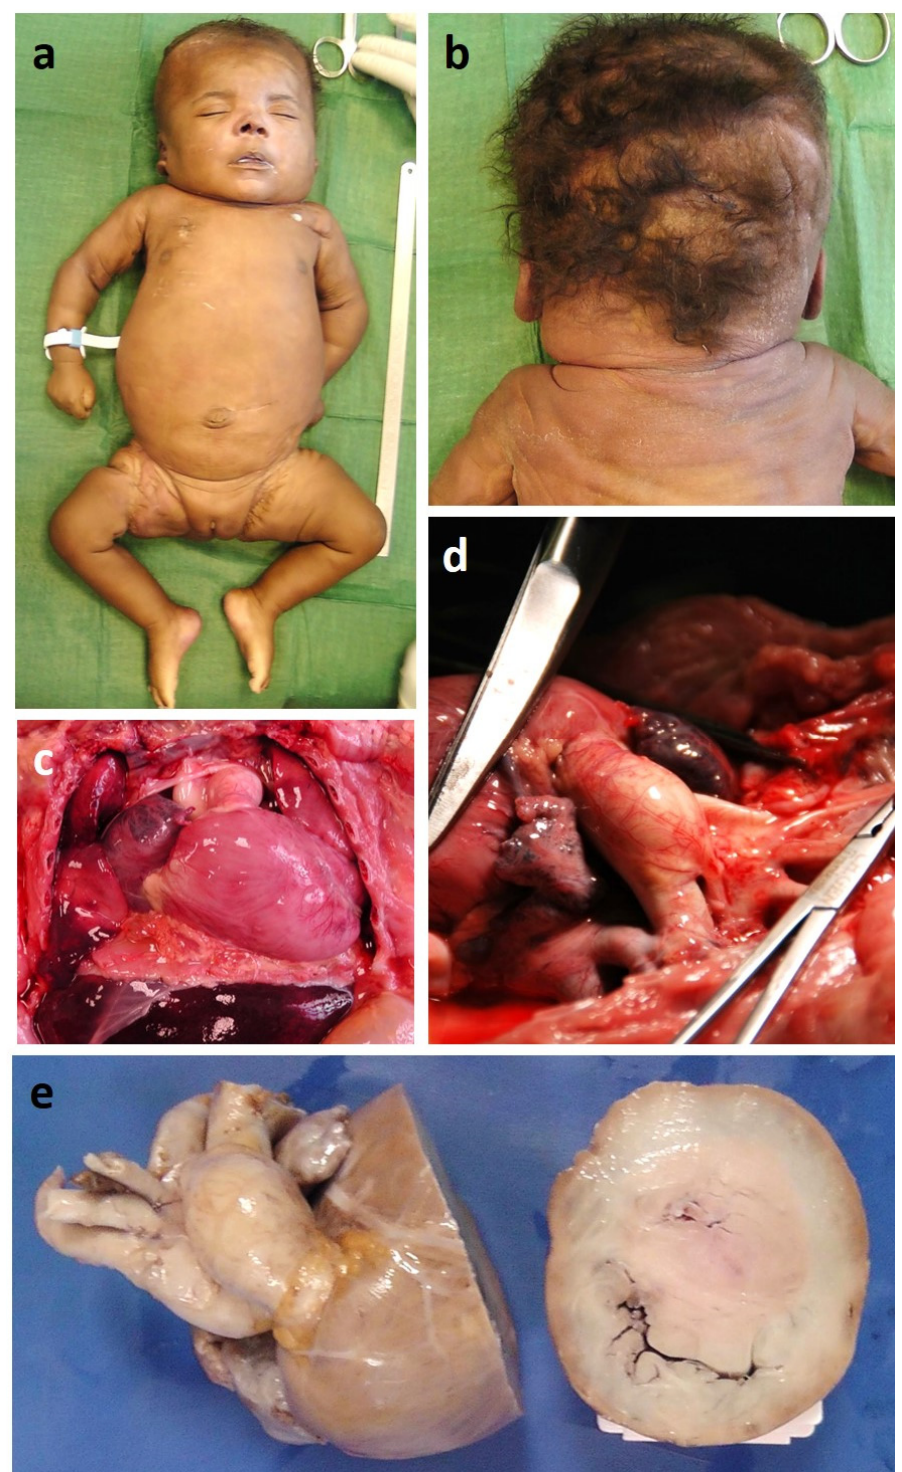
Figure 3. Gross pathology findings. Autopsy showed typical Noonan syndrome (NS) features with low-set posteriorly rotated ears, high anterior hairline with wide forehead and narrow temples, mild hypertelorism, downslanting palpebral fissures, broad nose, full tip with deeply grooved philtrum ( a ), pterigium colli, short webbed neck ( b ), severe obstructive HCM ( c , e ), dilation of pulmonary artery trunk and branches ( d ).